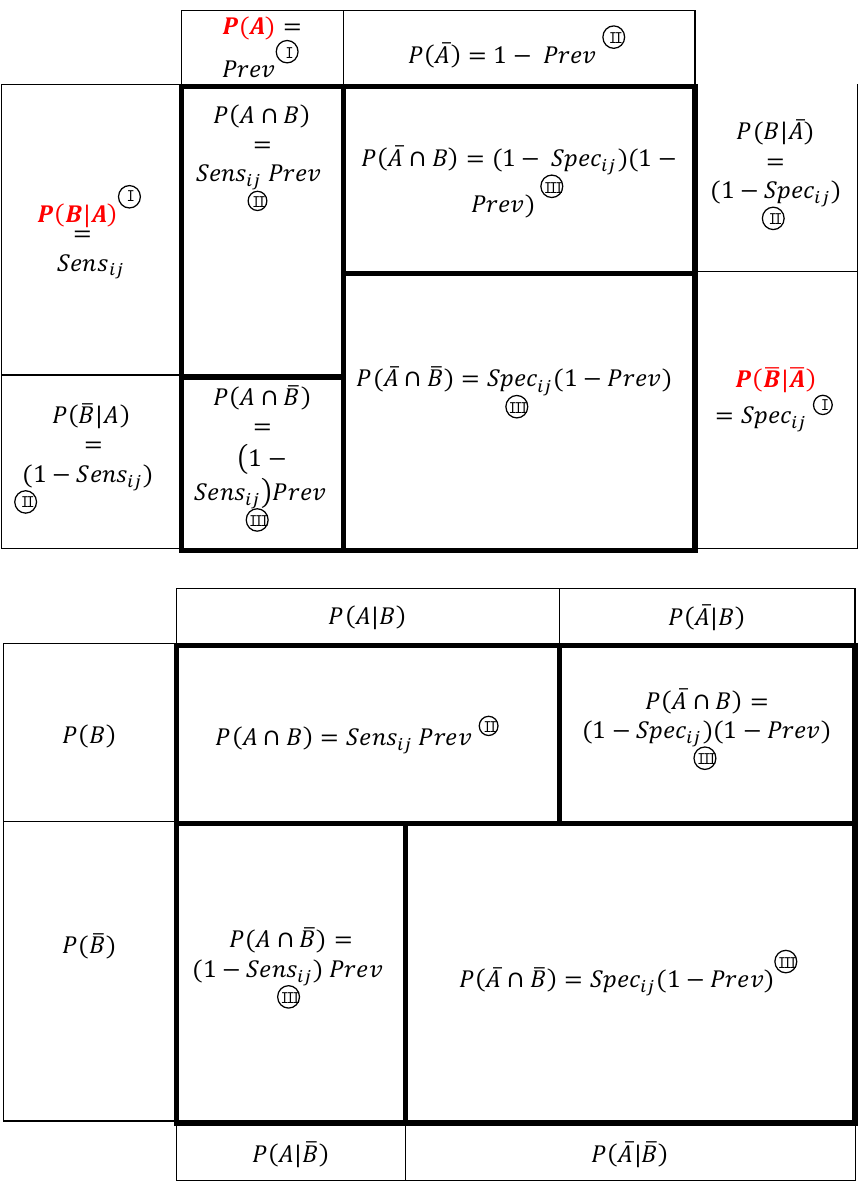
Figure 10. Derivation of expressions for the predictive values 𝑃𝑃𝑉 terms of the prevalence (𝑃(𝐴)) , 𝑆𝑒𝑛𝑠